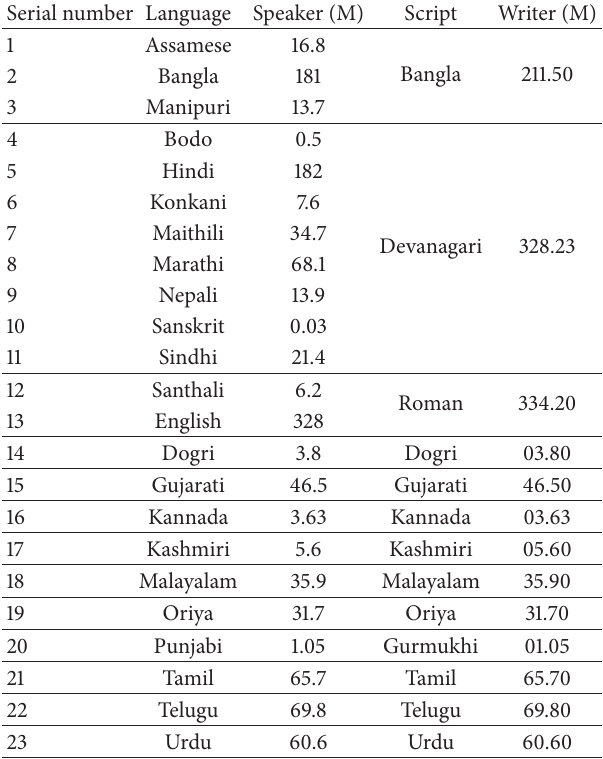
Table 1: Official language of India with total speaker and its script